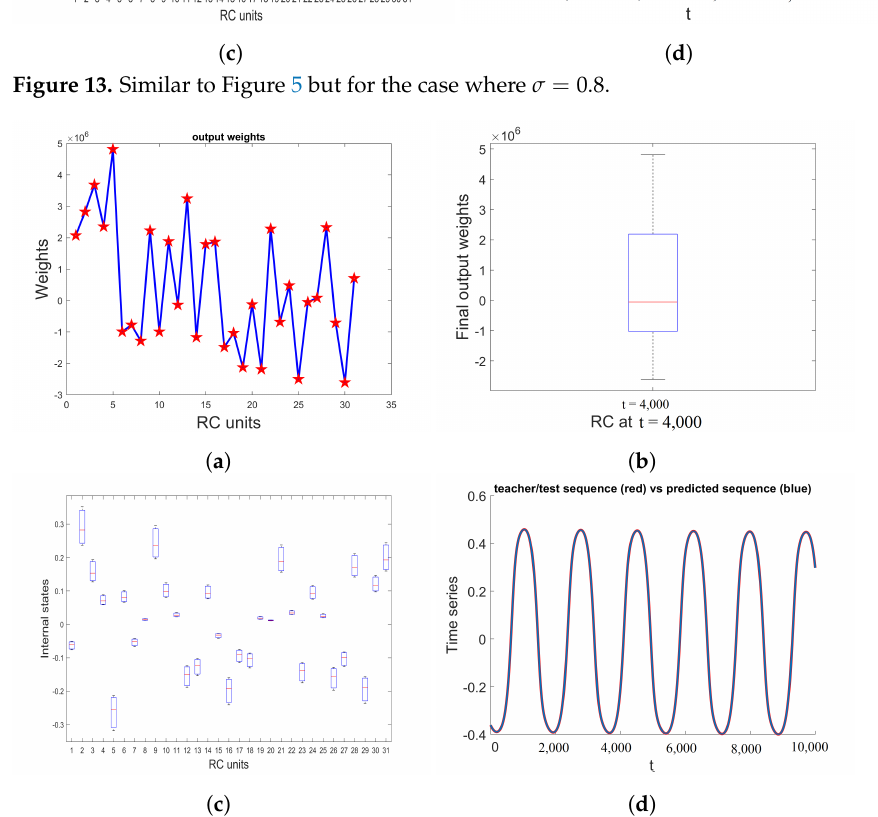
Figure 14. Similar to Figure 6 but for the case where σ =